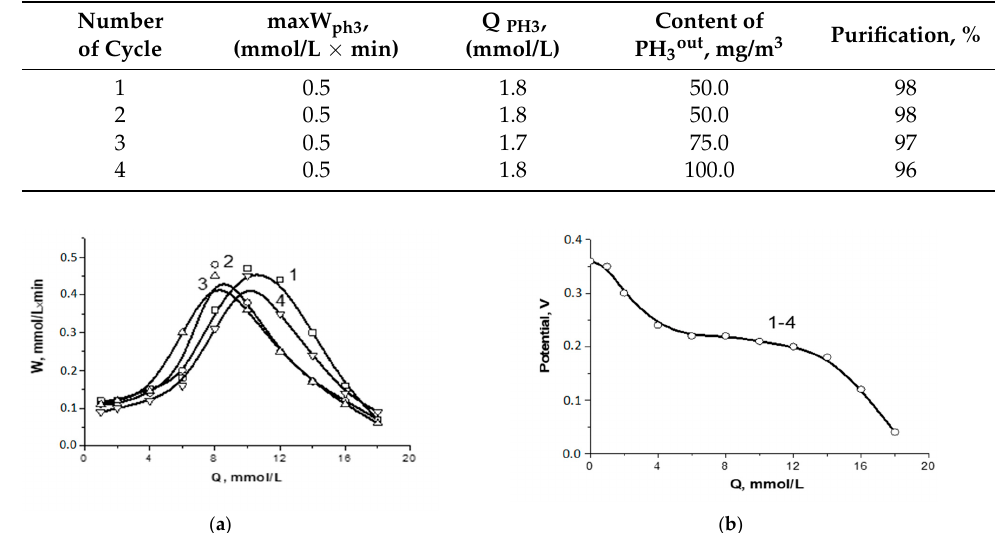
Figure 3. Kinetic ( a ) and potentiometric ( b ) curves of PH 3 oxidation by aqueous copper–ammonia complexes at t = 30 ◦ C, C PH3in = 2500 mg/ m 3 , X(PH 3 ) = 98–99%, solution composition, mol/L: NH 4 OH—0.65; H 3 PO 4 —0.95; and CuSO 4 —0.4; 1–4—cycle